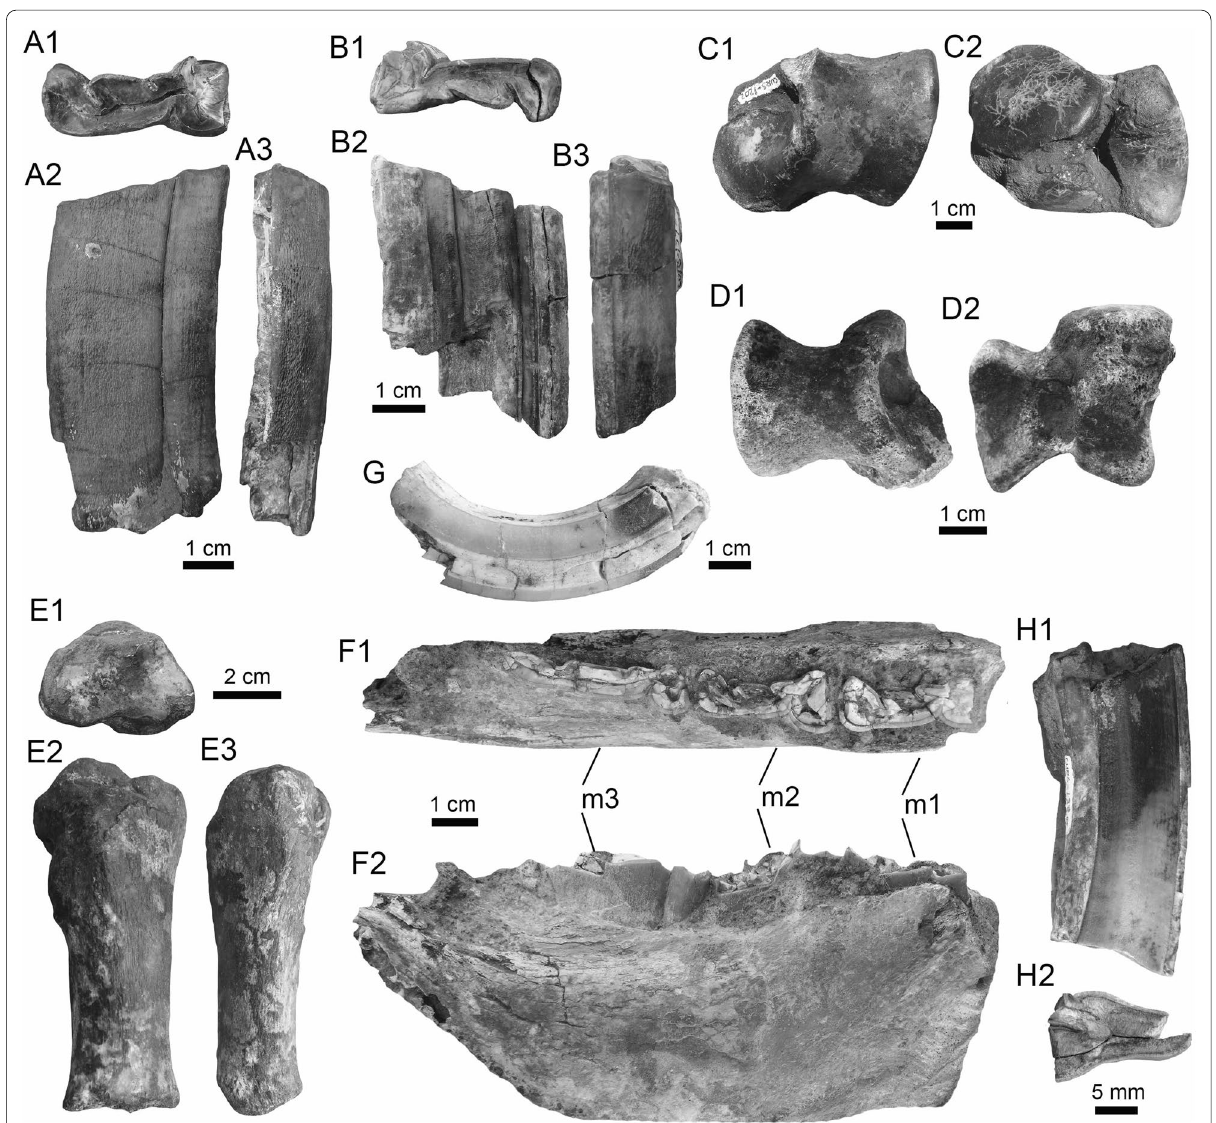
Fig. 25 Notoungulata (Toxodontidae) from the Vergel ( A1 – E3 ) and Cocuiza ( F1 – H2 ) members. A1 – E3 Falcontoxodon sp. A1 – B3 Right lower molars, m1 or m2 ( A1 – A3 AMU‑CURS‑1345 and B1 – B3 AMU‑CURS‑1348). C1 – D2 Astragali. C1 , C2 Left astragalus (AMU‑CURS‑1202). D1 , D2 Right astragalus (AMU‑CURS‑1330). E1 – E3 Metatarsal IV (AMU‑CURS‑1118). F1 – H2 Toxodontinae indet. F1 , F2 Right partial mandible (AMU‑CURS‑1351). G Upper incisor (AMU‑CURS‑1326). H1 , H2 Upper left molar (AMU‑CURS‑1325). Views: anterior ( E1 ), lateral ( E3 , F2 ), distal ( A3 , B3 ), dorsal ( C1 , D1 , E2 ), plantar ( C2 , D2 ), labial ( A2 ), lingual ( B2 , G , H1 ), and occlusal ( A1 , B1 , F1 , H2